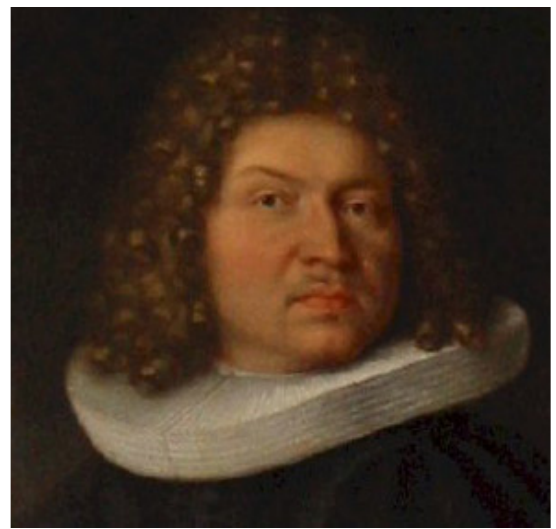
Figure 5: Jakob Bernoulli: towering mathematician and physicist of the 1700s and early